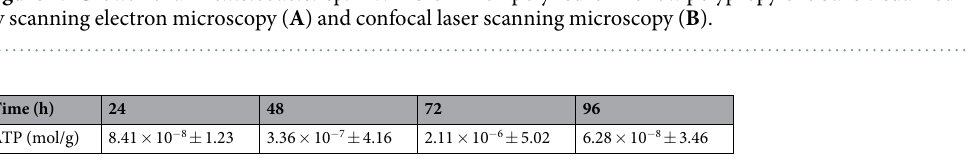
Table 1. Adenosine tri-phosphate (ATP) analysis of Acinetobacter sp. DW-1 immobilized on polyhedron hollow polypropylene balls at different